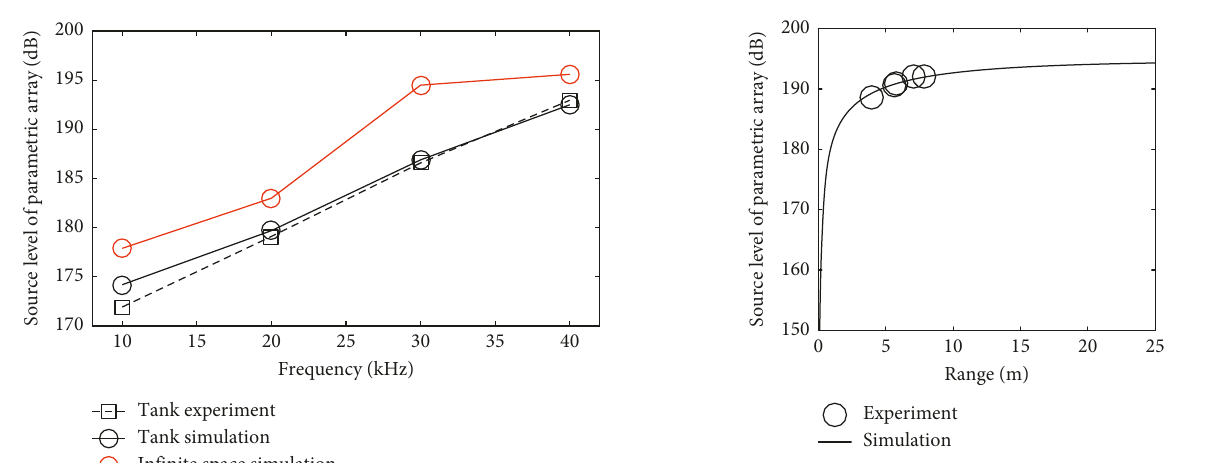
Figure 4: Parametric array length measured by the source level. Table 1: Penetration depth of the difference frequency